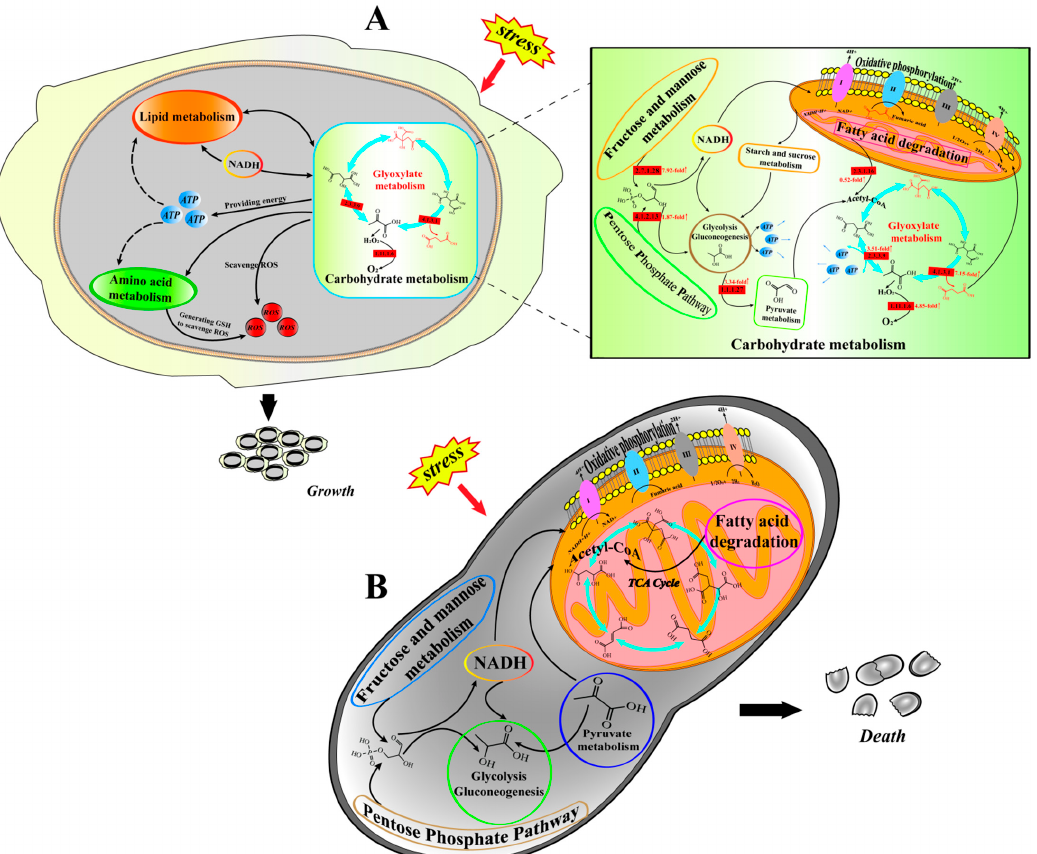
Figure 7. Mechanic maps of stress resistance in SCs ( A ) and YL ( B ) in Aureobasidium pullulans NG . The red chemical formulas in the graph are the key antioxidant metabolites, citric acid, and succinic acid, respectively. The red squares are upregulated genes followed by the upregulation multiplier.